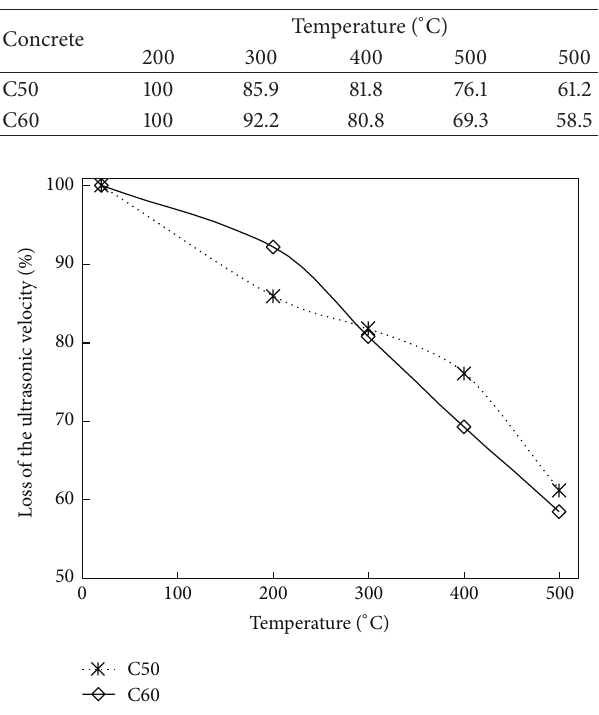
Figure 9: Loss of the ultrasonic velocity at elevated